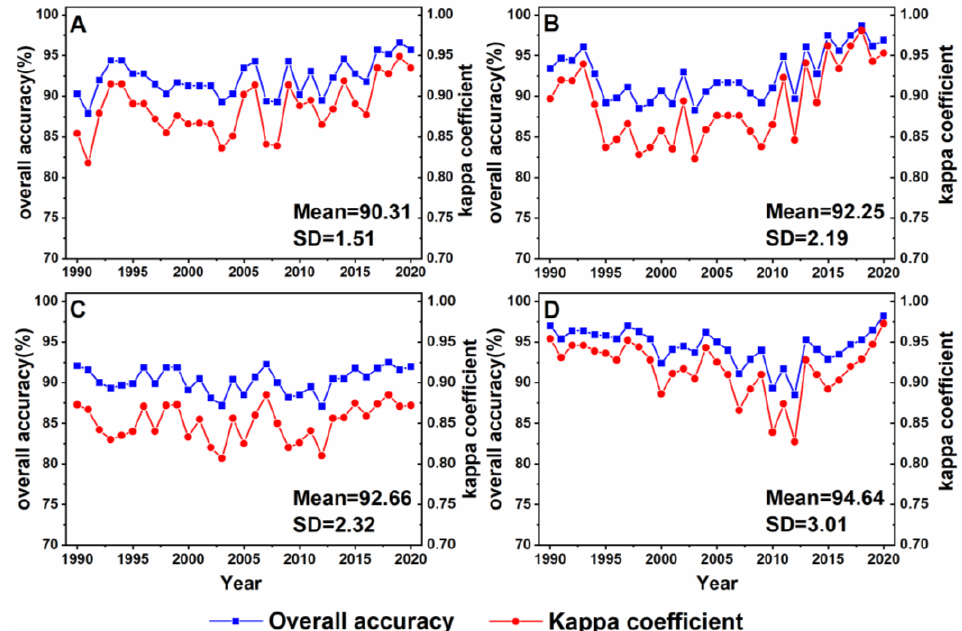
Figure 8. OA and Kappa coefficient of urban wetland mapping in this study. ( A–D ) show OA and Kappa coefficient of urban wetland mapping in four study sites (Site(A–D)) from 1990 to 2020, respectively.